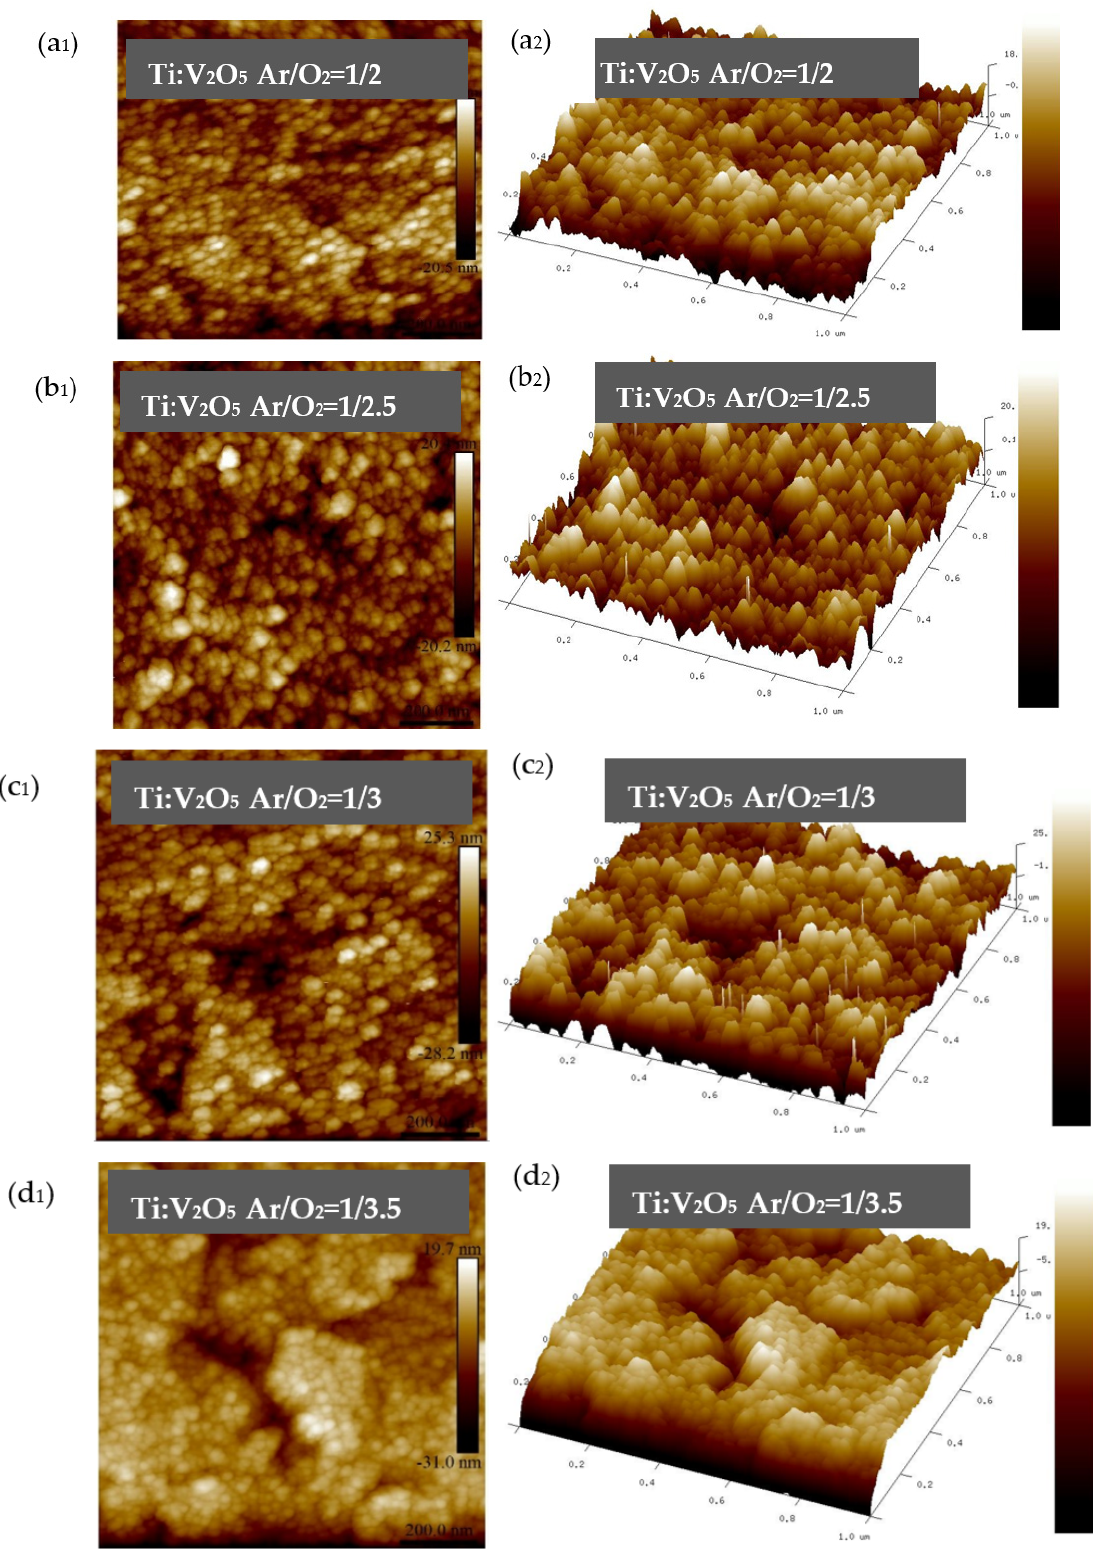
Figure 6. ( a 1 – d 1 ) 2D AFM visualization of Ti:V 2 O 5 film; ( a 2 – d 2 ) 3D AFM visualization of Ti:V 2 O 5 film. Figure 6. ( a1 – d1 ) 2D AFM visualization of Ti:V 2 O 5 film; ( a2 – d2 ) 3D AFM visualization of Ti:V 2 O 5